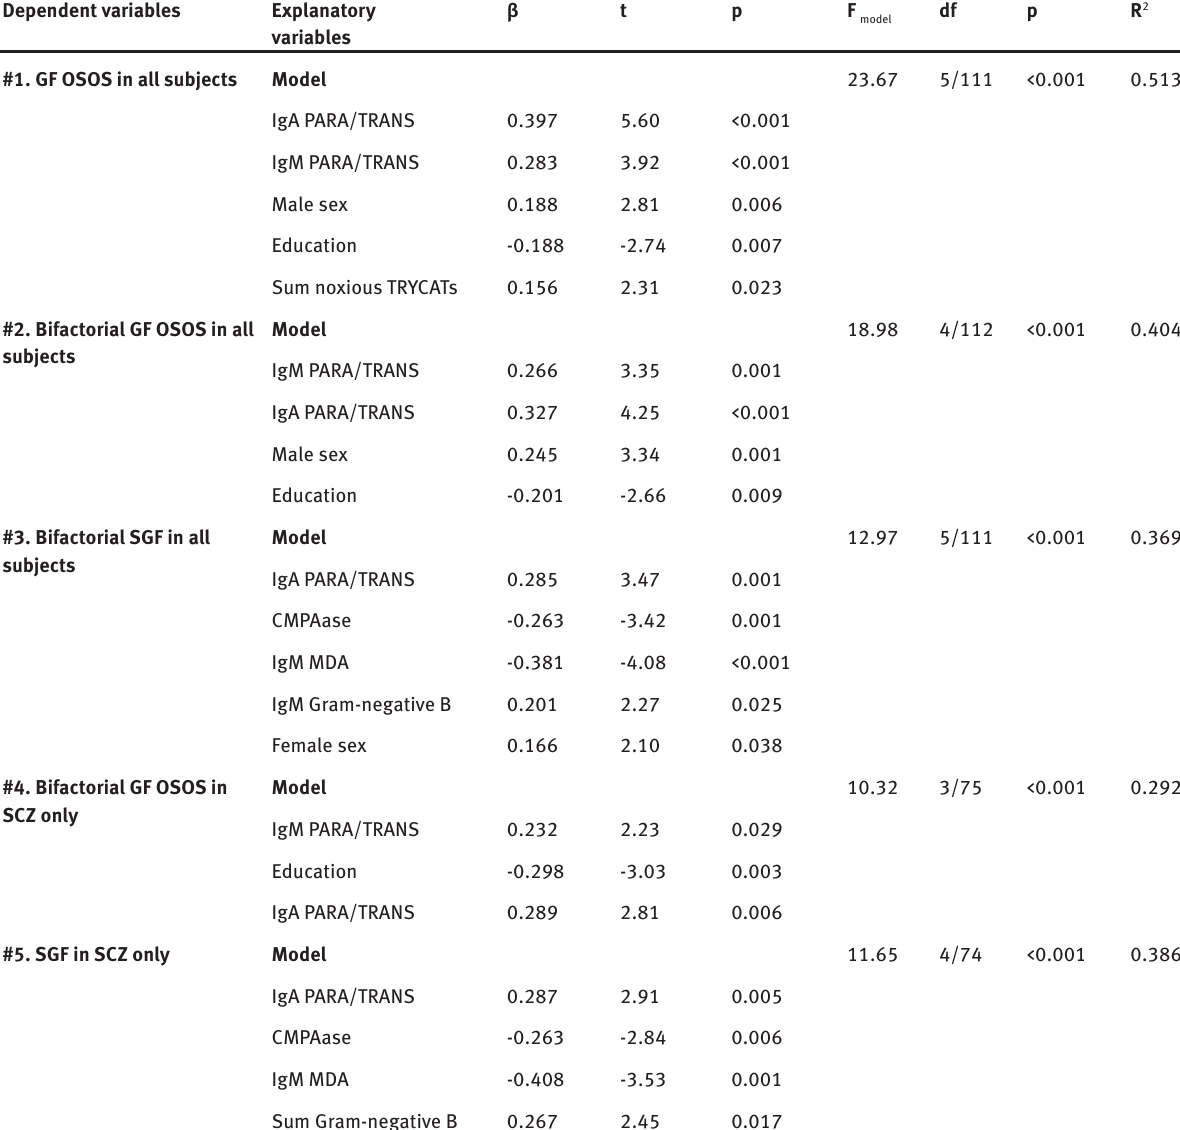
Table 5: Results of multiple regression analyses with the (bifactorial) general factor (GF) OSOS (overall severity of schizophrenia) and the single group factor (SGF) as dependent variables and the biomarkers as explanatory